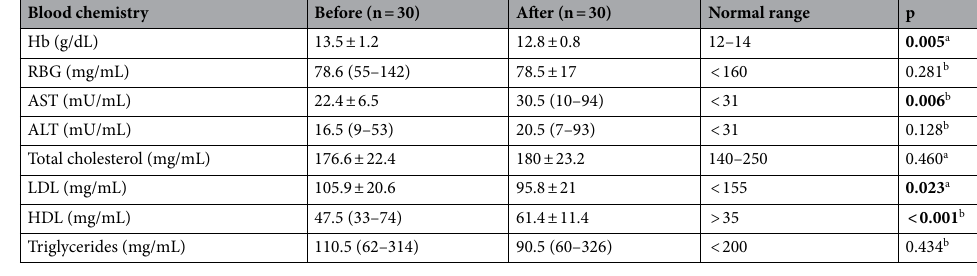
Table 2. Blood chemistry profile before and 6 months after one-rod implant insertion. Bold values indicate when the levels of Hb, RBG, AST, total cholesterol, LDL, and HDLcholesterol were slightly increase or decrease but still in a normal range. a Paired T-test. b Wilcoxon test.